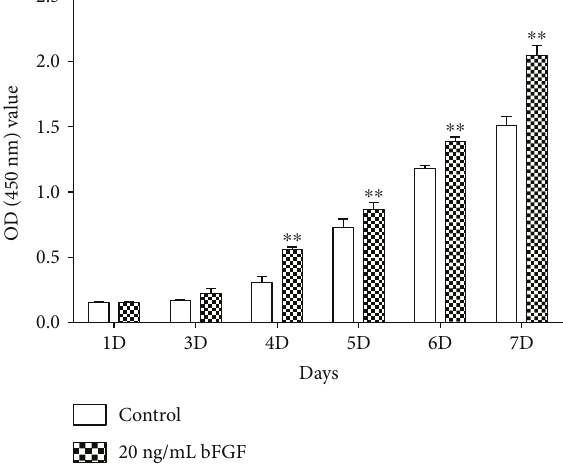
Figure 4: The cell proliferation of DPSCs after bFGF promotion at day 1, 3, 4, 5, 6, and 7. ∗∗ P < 0 01 versus the control